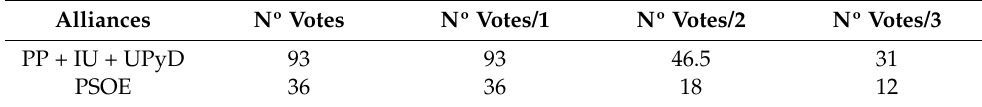
Table 7. Alliances and d’Hondt allocation in the IX Legislature. Alliances Nº Votes Nº Votes/1 Nº Votes/2 Nº Votes/3 PP + IU + UPyD 93 93 46.5 PSOE